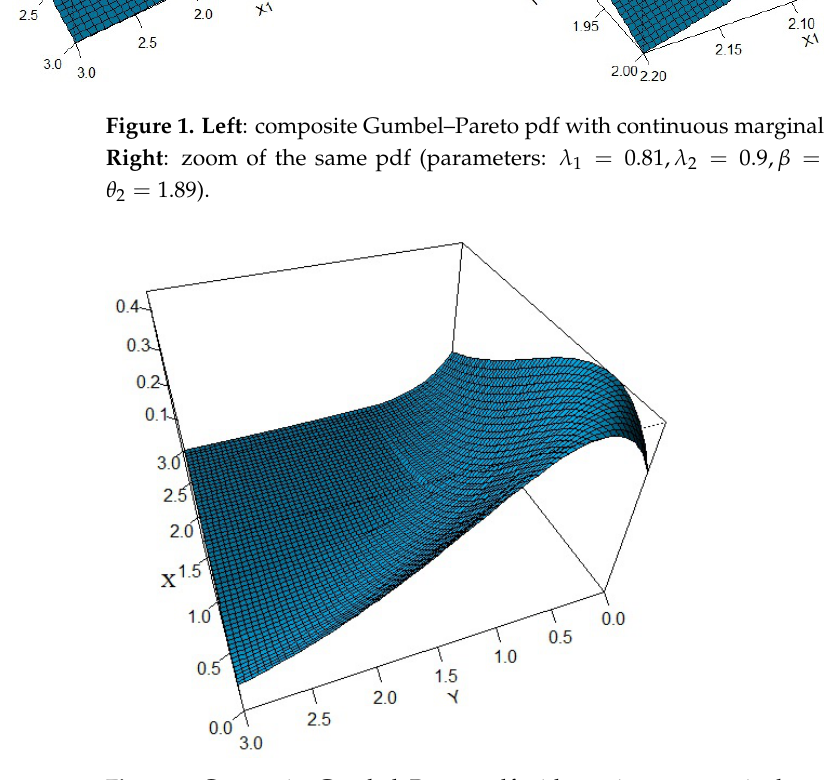
Figure 2. Composite Gumbel–Pareto pdf with continuous marginals and continuity at ( θ 1 , θ 2 ) (pa- rameters: λ 1 = 1, λ 2 = 1.2, β = 0.7, a = 0.7515, θ 1 = 1.2, θ 2 = 1 )